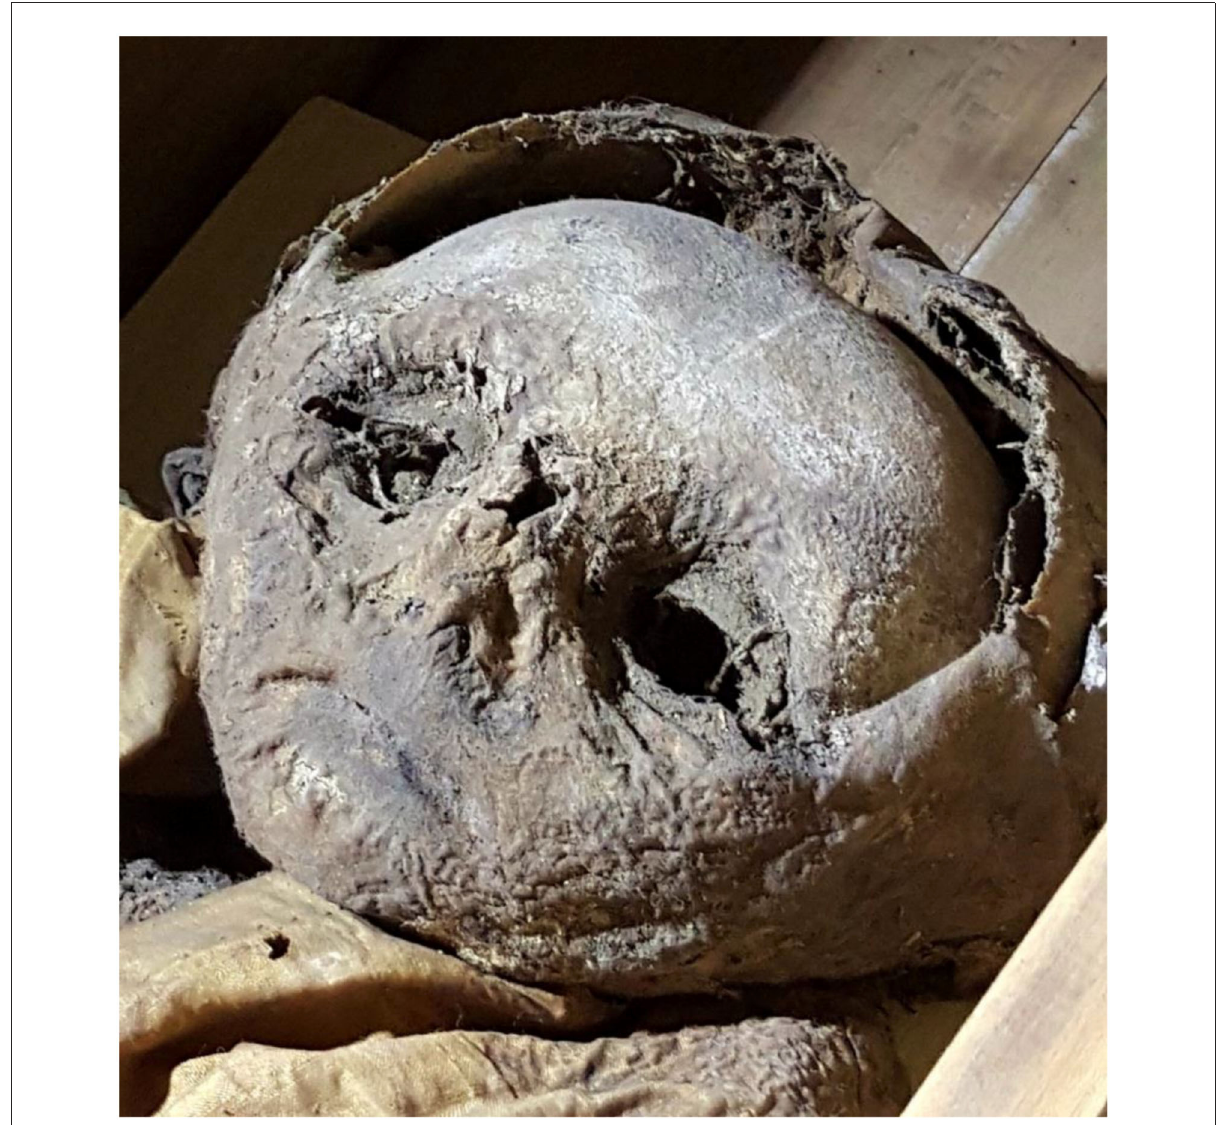
FIGURE3 Detail of the mummy’s face. Note here the defects of the skin at the chin and nose and the gap between the frontal bone and the silk hood.